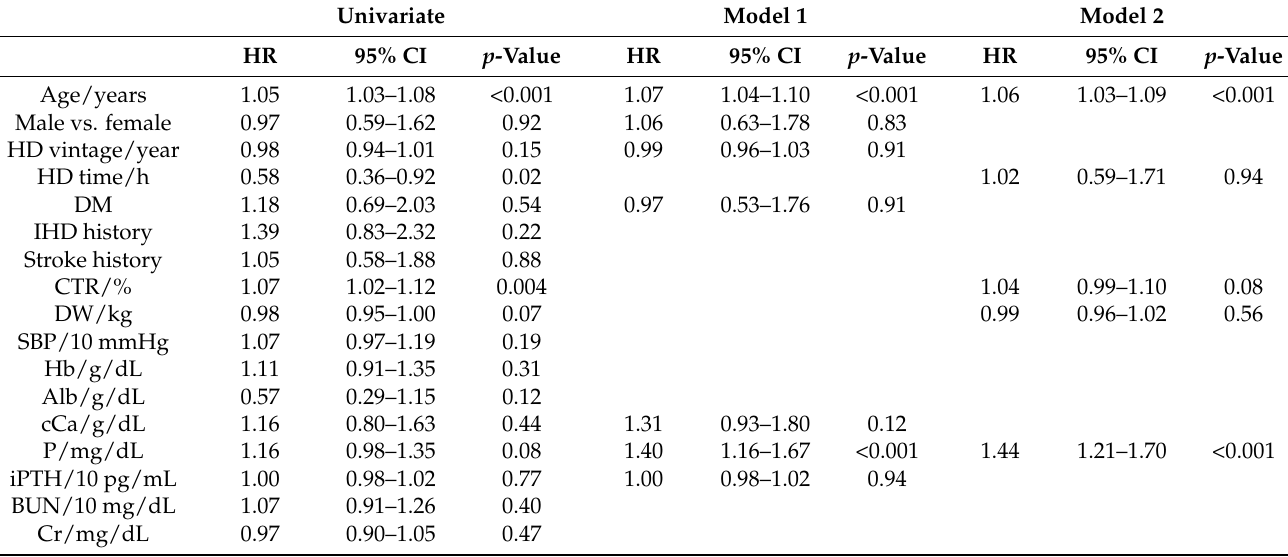
Table 2. Univariable and multivariable Cox proportional regression models for the risk of developing aortic